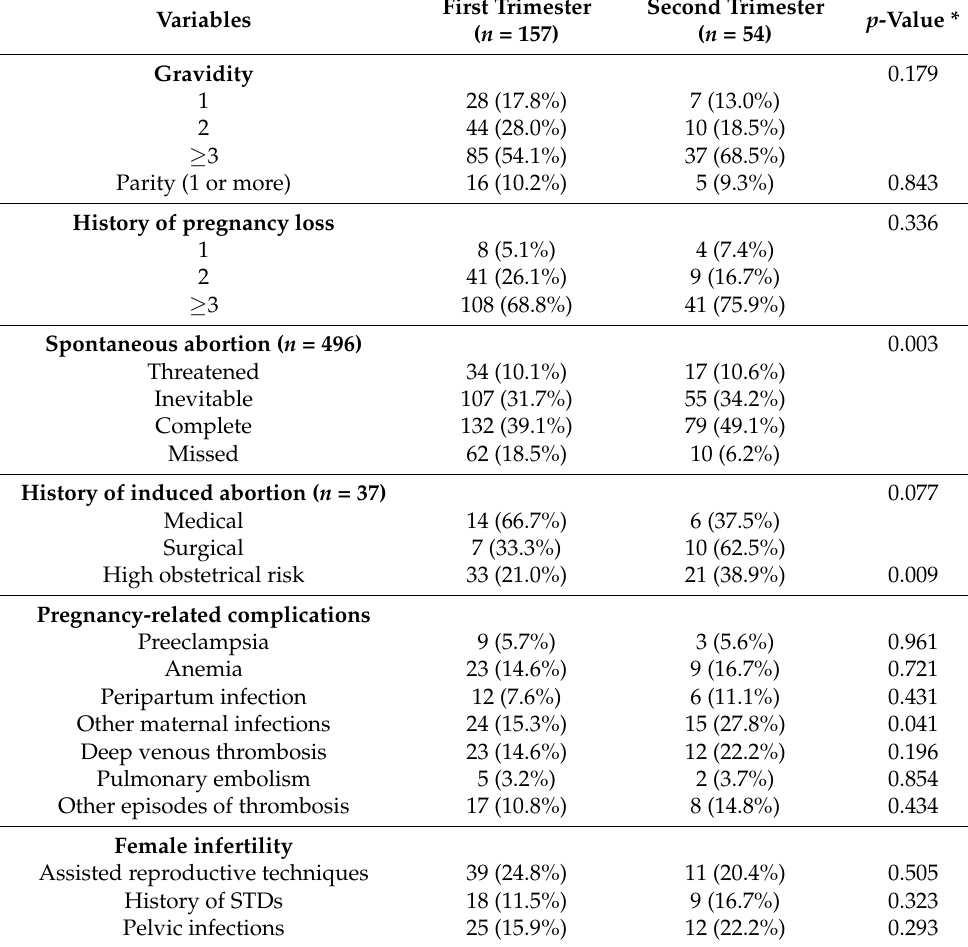
Table 2. Comparison of obstetrical characteristics between women with a history of first trimester and second trimester pregnancy